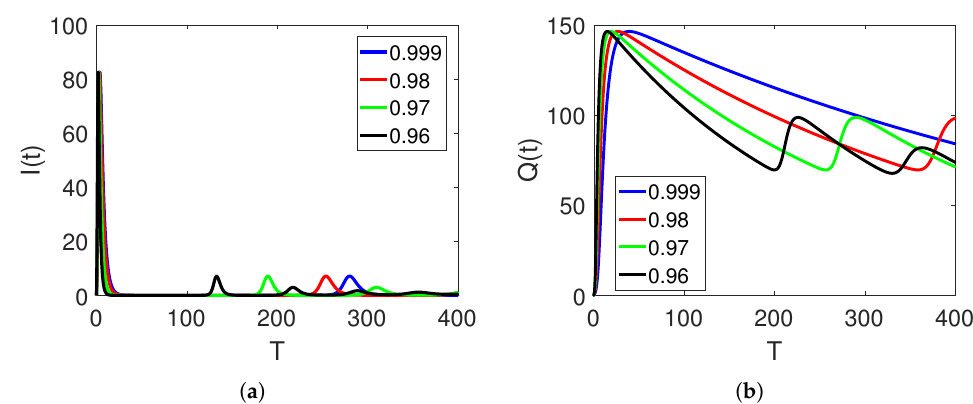
Figure 5. Dynamics of the infected class ( a ) and quarantined class ( b ) on different arbitrary fractional order ς on sub interval [ 0, t 1 ] and [ t 1 , T ] of [ 0, T ] for different time duration.